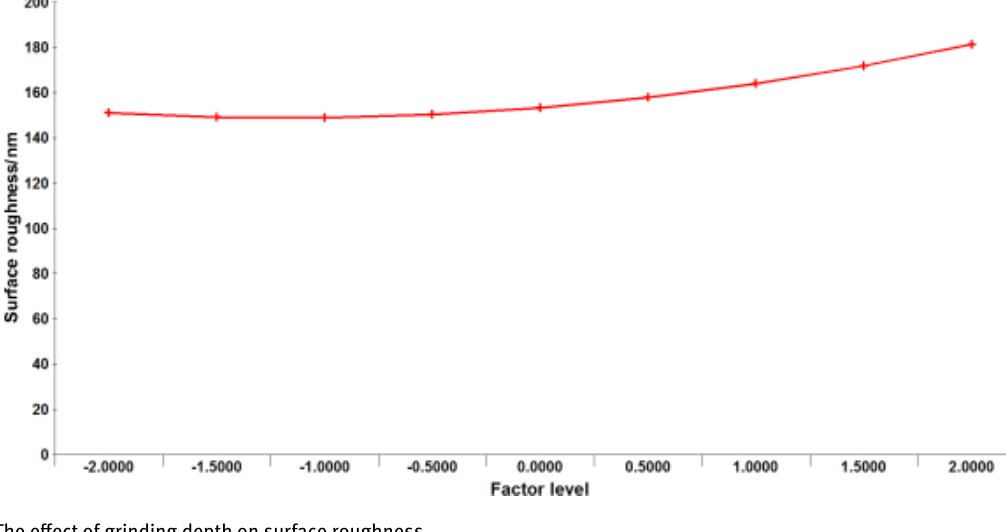
Figure 8: The effect of grinding depth on surface roughness